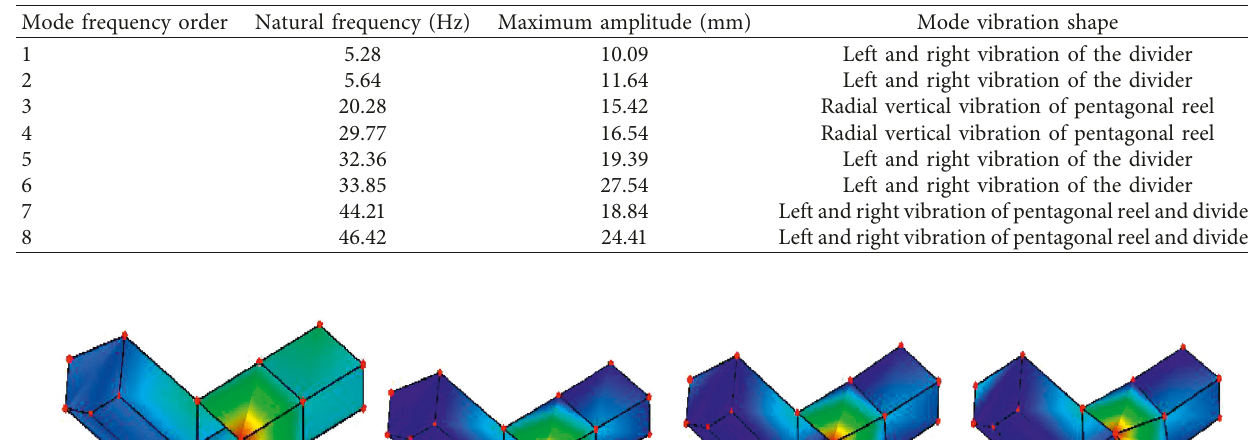
Table 1: Mode vibration frequency and shape of front header.